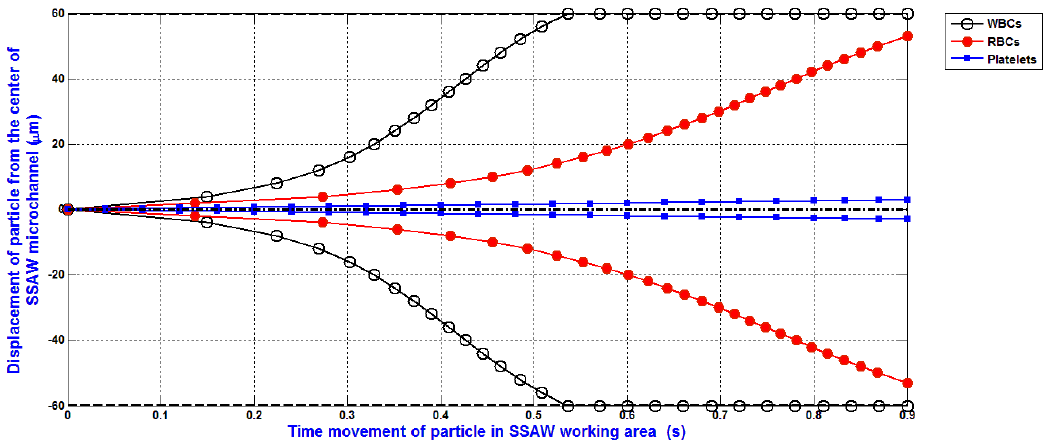
Figure 10. The separation of blood components (WBCs, RBCs, and platelets) based on the design analysis of SSAW microfluidics and the SSAW force only.